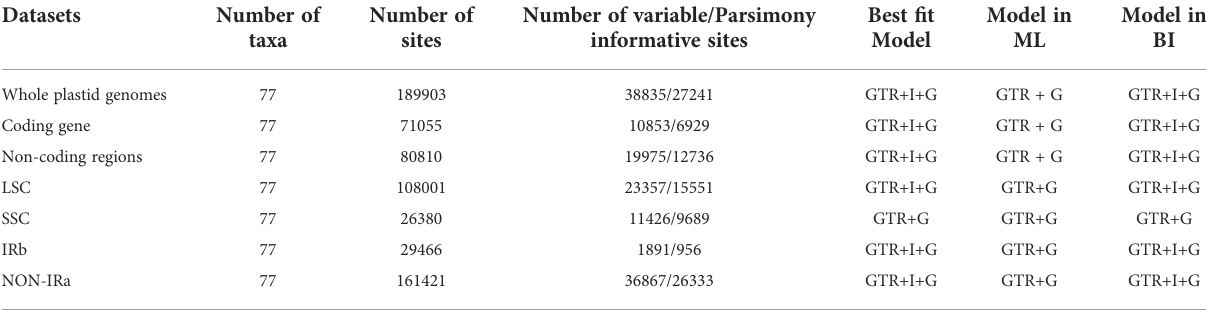
TABLE 3 Characteristics and models selected for different datasets in ML and BI analysis.